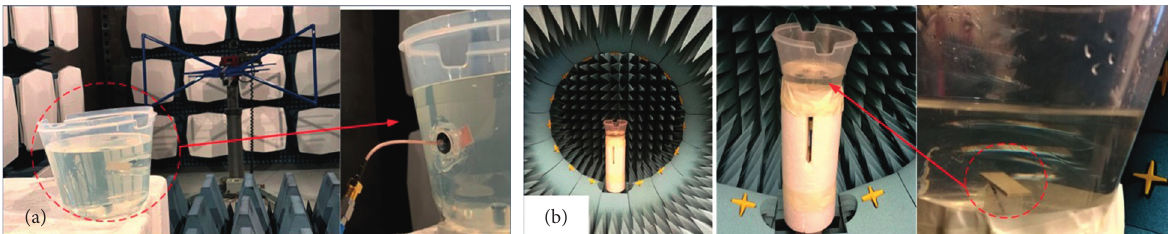
Figure 9: Measurement setup of implantable PIFA in liquid at the depth of 13.25mm in (a) anechoic chamber and (b) SATIMO Starlab anechoic chamber.